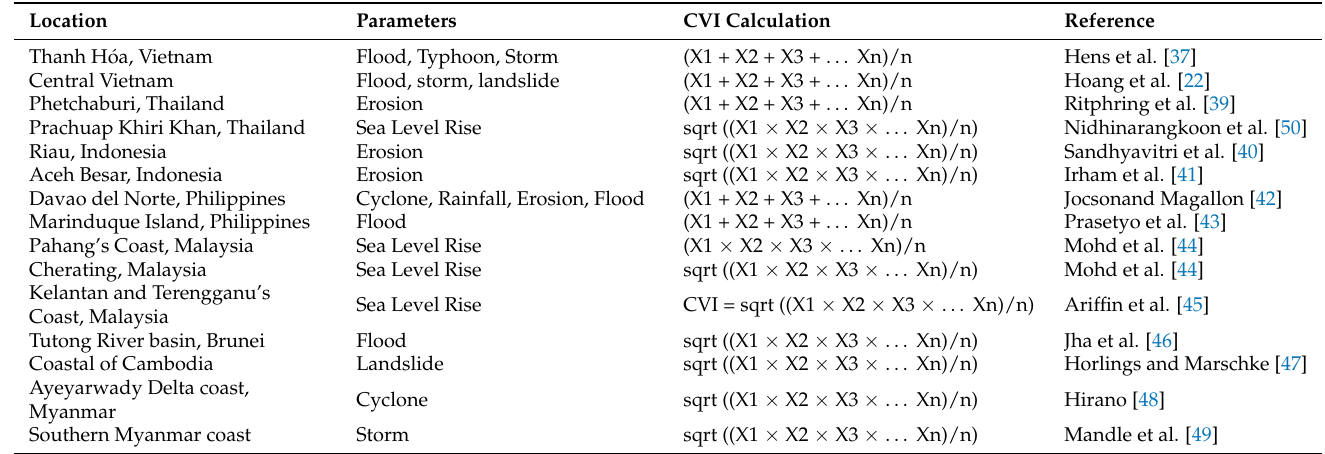
Table 2. A summary of location, parameters, and calculation of CVI in Southeast Asia for the past five